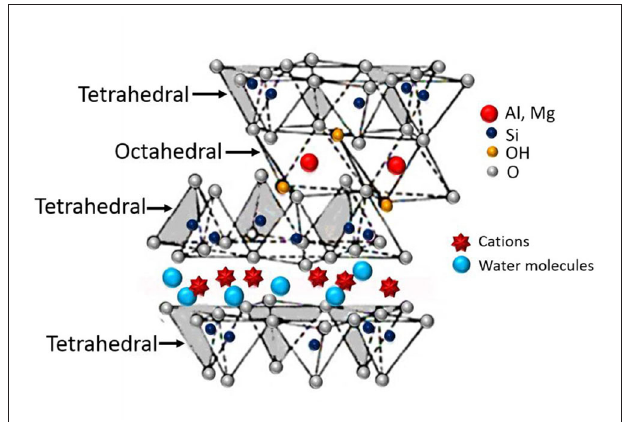
FIGURE 3 | Schematic illustration of cationic clay (Ghadiri et al., 2015).